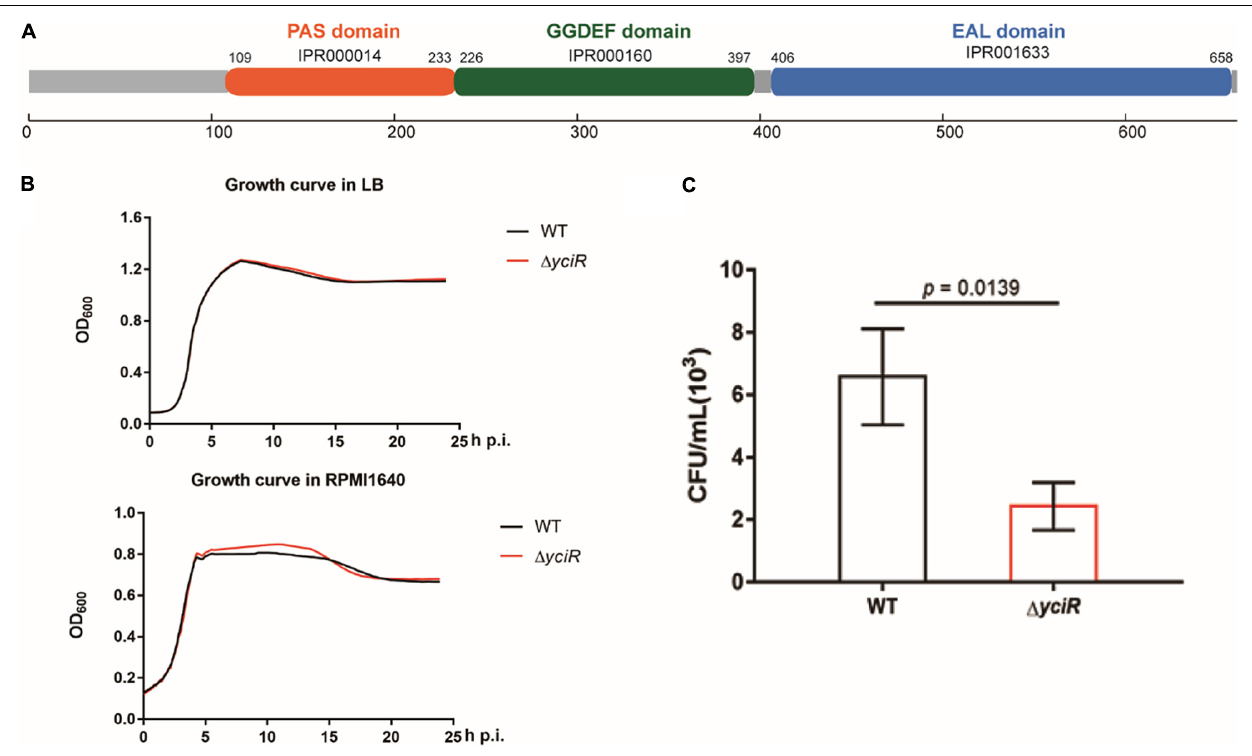
FIGURE 2 | Features of YciR. (A) Domain identification of YciR. (B) Growth curves of WT and (cid:49) yciR . Growth curves of WT and (cid:49) yciR strains cultured in LB broth. Growth curves of the WT and (cid:49) yciR strains cultured in RPMI 1640. The overnight cultured strains were diluted at a ratio of 1:1,000 and then cultured under different conditions in LB broth or RPMI 1640. The spectrophotometric value was measured at OD 600 every 10 min. (C) yciR impacted the invasion of BEC infection. The 5637 bladder cell line was seeded in 24-well plates and then infected with WT and yciR mutant strains for 8 h. CFU counts of triplicate wells were representative of three independent experiments (two-tailed t -test).